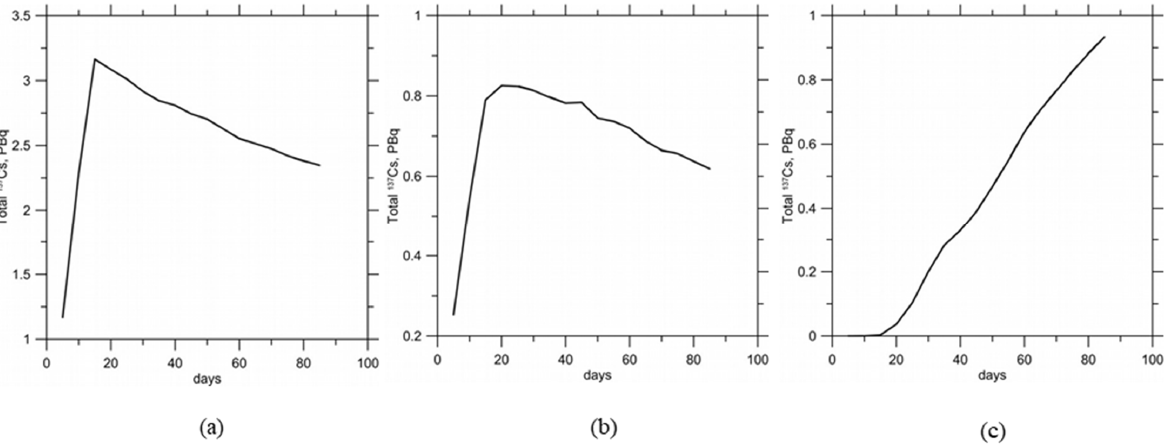
Figure 16. ( a ) Total amount of dissolved 137 Cs after release from the Hongyanhe NPP; ( b ) total amount of 137 Cs adsorbed on suspended sediments after release from the Hongyanhe NPP; ( c ) total amount of bottom contamination of 137 Cs after release from the Hongyanhe NPP.